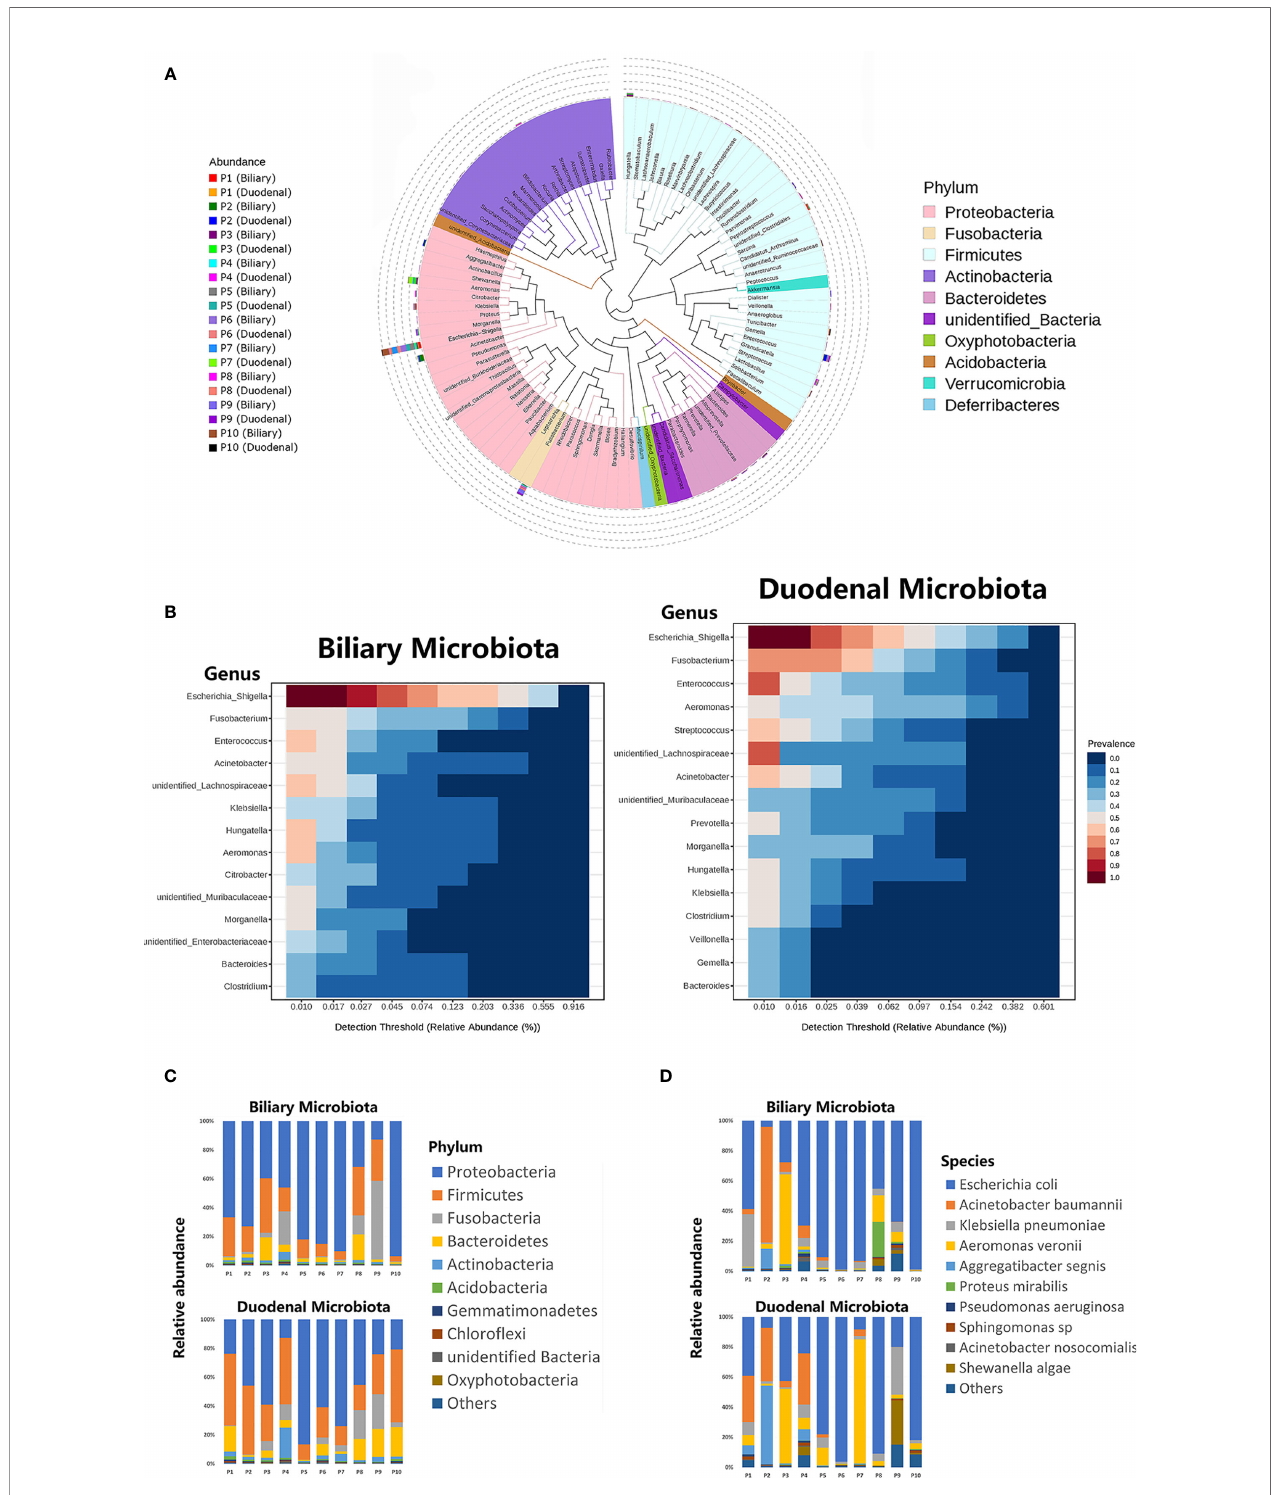
FIGURE 1 | Composition of biliary and duodenal microbiota of patients with choledocholithiasis. (A) Phylogenetic trees for biliary and duodenal microbiota ( “ P ” stands for patient). (B) Core microbiota of biliary and duodenal microbiota. (C) Microbial communities of biliary tree and duodenum at the phylum level. (D) Microbial communities of biliary tree and duodenum at the species level in the phylum Proteobacteria